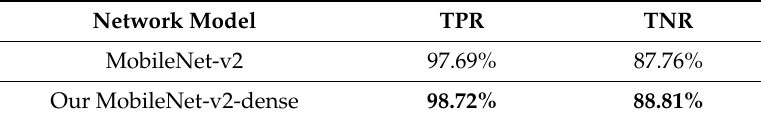
Table 7. Compared with MobileNet-v2, the TPR / TNR of our MobileNet-v2-dense is improved. Table 7. Comparison of TPR / TNR of di ff erent networks.